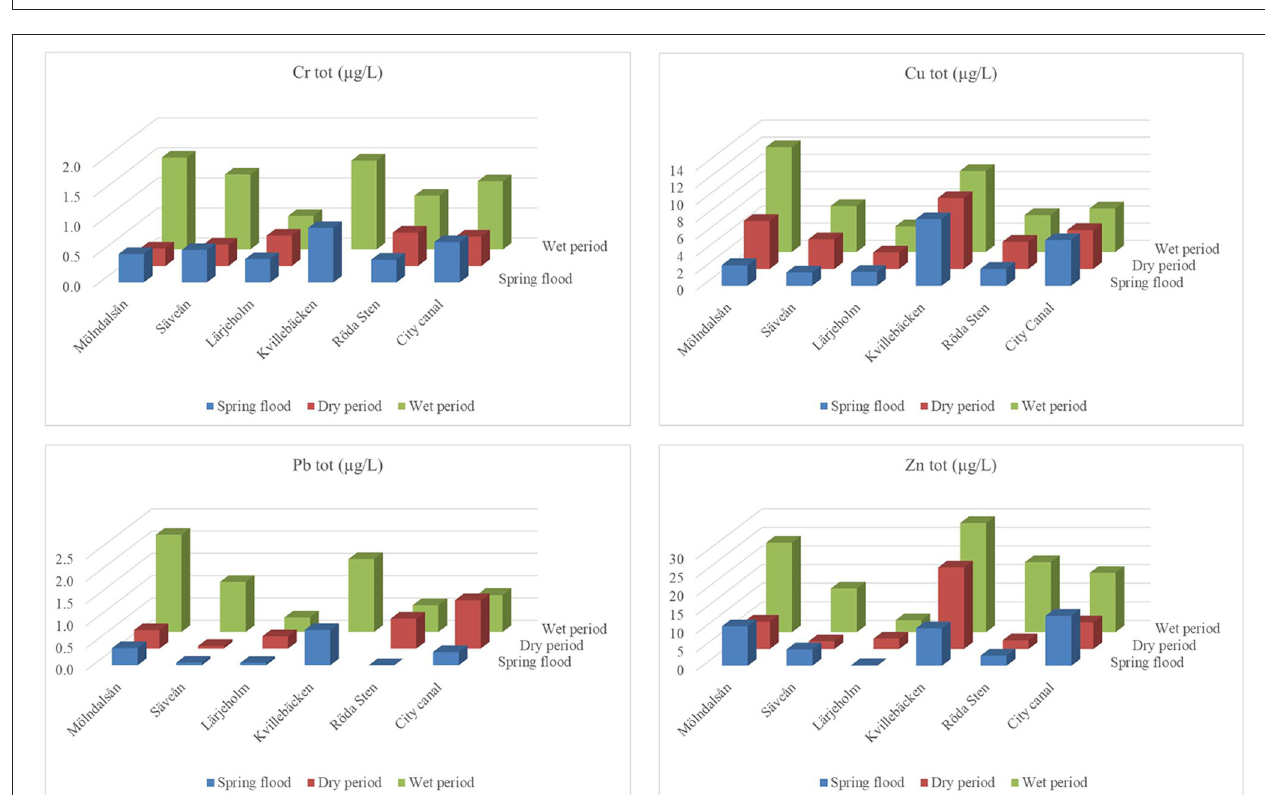
FIGURE 4 | Total concentrations of Cu, Zn, Cr, and Pb at sampling sites during the Spring flood, Dry period, and Wet period sampling campaigns. Figure 5 show Cr, Cu, Pb and Zn as particle bound during the Wet period, but there is a deviation with respect to Cu concentrations and in Figure 6 as dissolved metals. The and Pb at the sampling sites City Canal, respectively, Röda Sten, distribution between particle bound and dissolved phases (of that showed highest concentration of Cu during the Spring flood the total content) varies with metal. The particle bound and highest concentration of Pb during the Dry period.